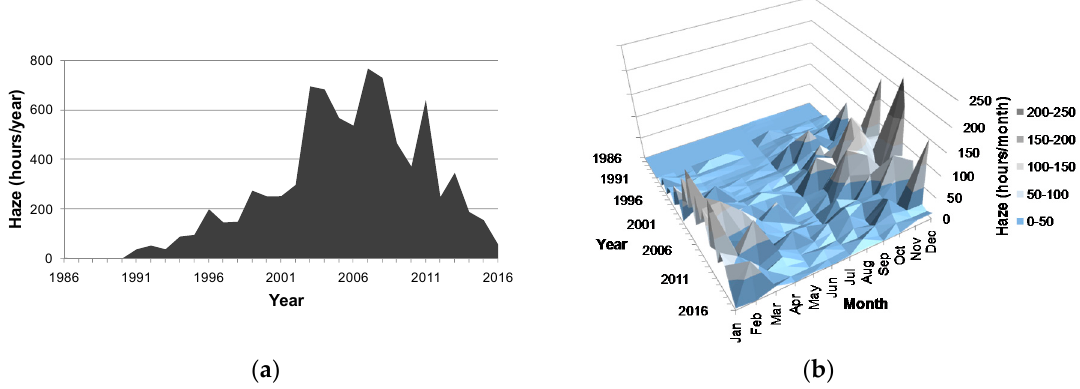
Figure 1. ( a ) The number of hours with haze per year for the period 1986 to 2016; ( b ) The number of hours with haze per month for the period 1986 to 2016.